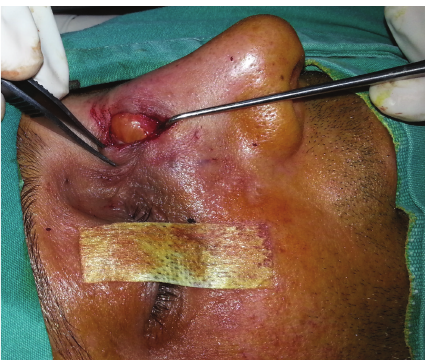
Figure 1: Intraoperative lateral view of the cystic formation on the nasal dorsum.